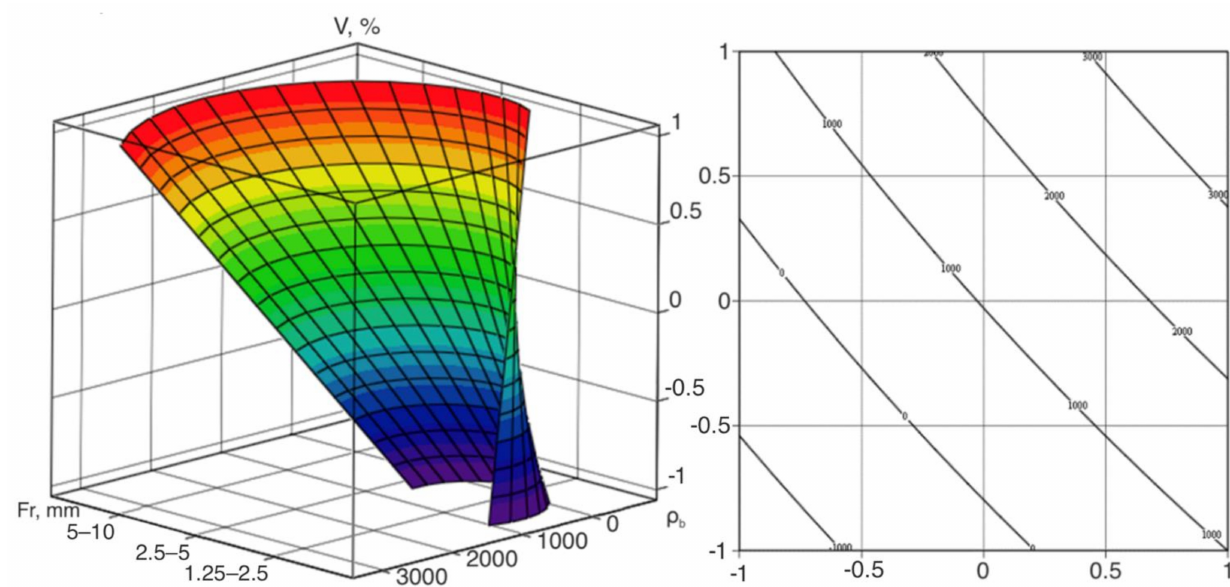
Figure 4. Dependence of the bulk density of a slag pumice mixture depending on the volumetric content of various types of fractions.